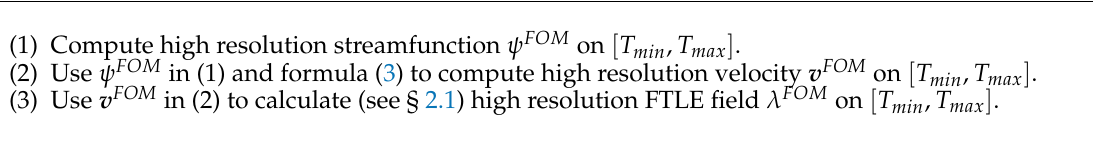
Algorithm 2. We also use two types of regimes: (i) the reconstructive regime; and (ii) the predictive regime. The two regimes have fundamentally different goals: The reconstructive regime is an